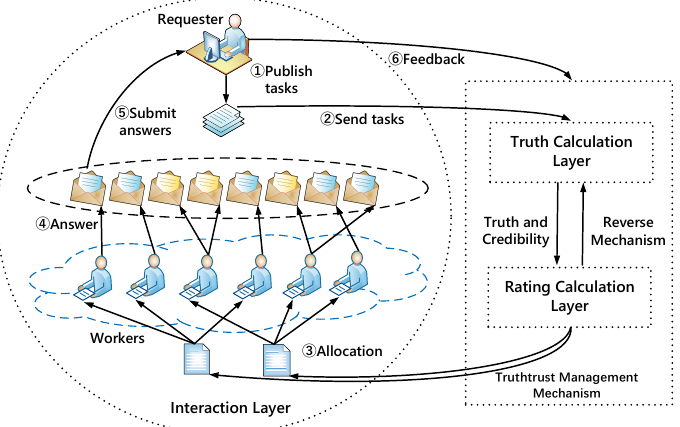
Figure 1. TruthTrust